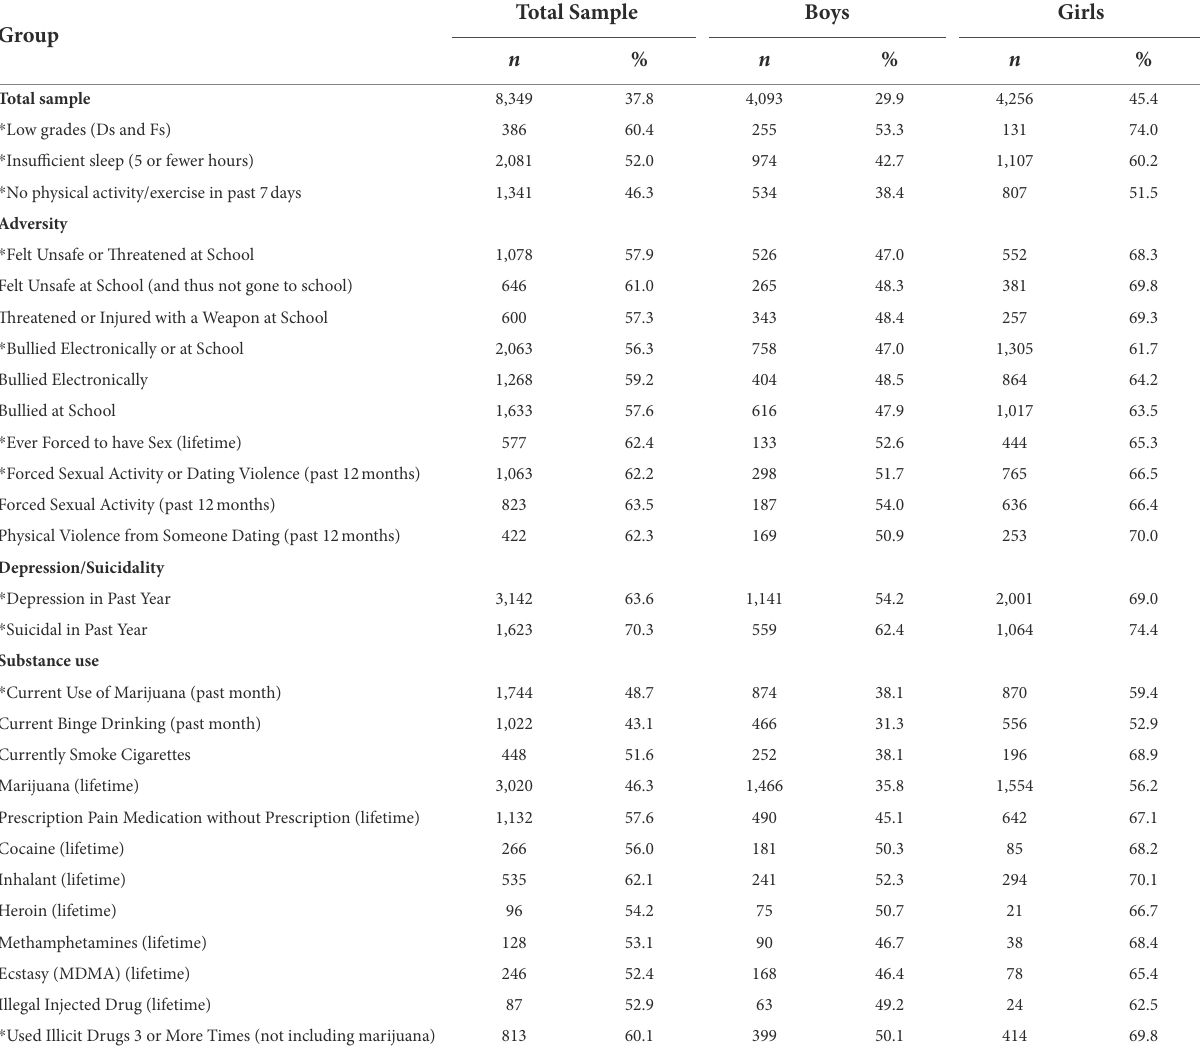
Total Sample Boys